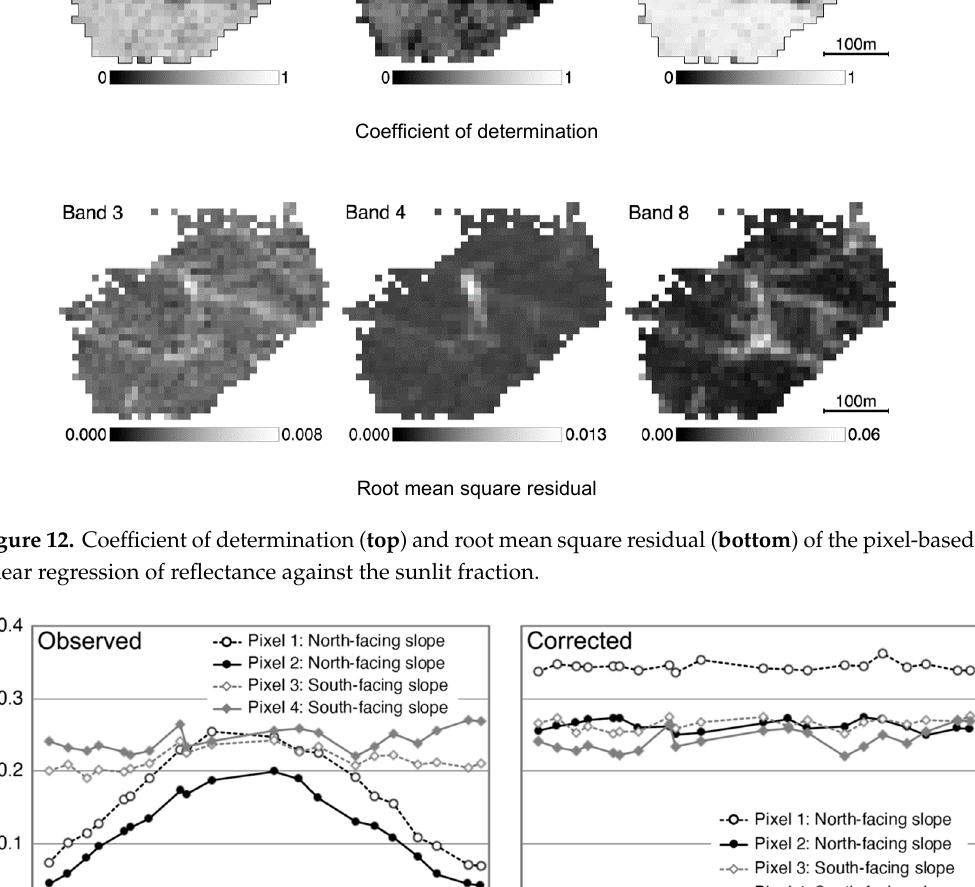
Figure 13. Time series of observed ( left ) and corrected ( right ) reflectance in the NIR band of the sample pixels over conifer trees. The pixel locations are shown in the DSM of Figure 5b.